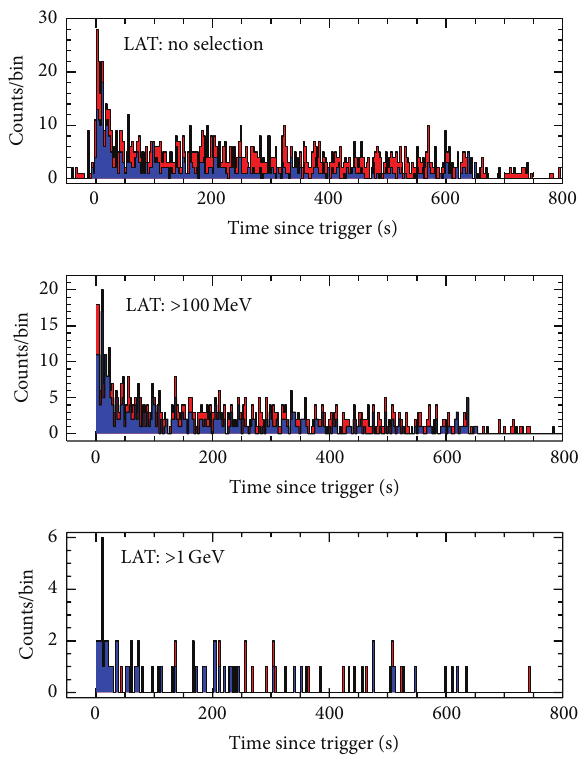
Figure 1: Fermi-LAT light curves for GRB130427A (bin size of 3 seconds). Photons selected within 10 degrees of the GRB130427A optical position. The contribution from the subset of photons within 3 degrees of the GRB130427A optical position is shown in blue.